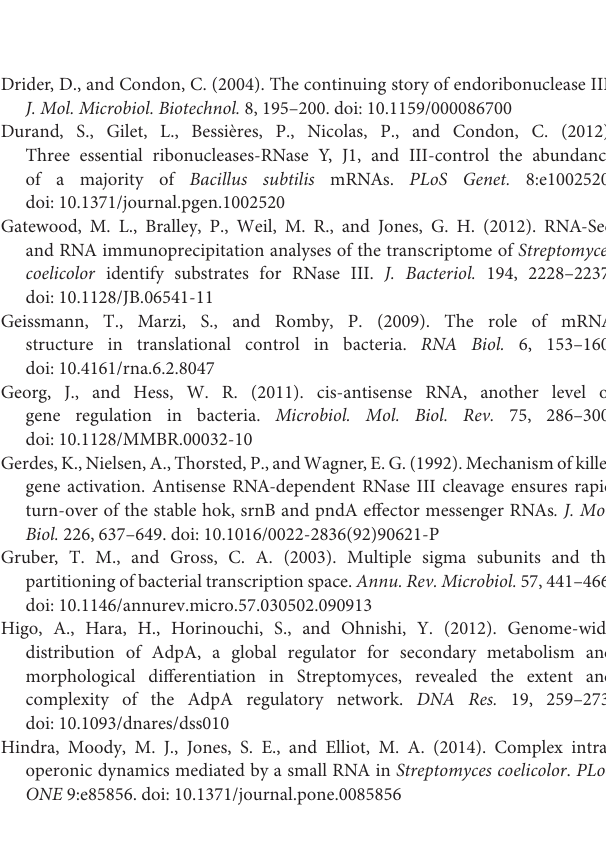
Figure S1 | SCO2100-SCO2101 RT-PCR. RNA samples were isolated from both wt (lane 1) and rnc (lane 2) 48h old cultures from the R2YE medium. The first probe TGTCCCGGCTGCTCCAGGGA primed the reverse transcription reaction and together with the second probe CGTAGGTCCCCGCCCGCT was used in the subsequent PCR. Additional samples originated from both strains but lacking reverse transcriptase in the reaction were used as negative controls (lanes 3 and 4). Table S1 | Description of the expression profiles of detected asRNAs. Table S2 | Quantification of the northern blot signals presented in Figure 2. Presentation 1 | Raw northern blot